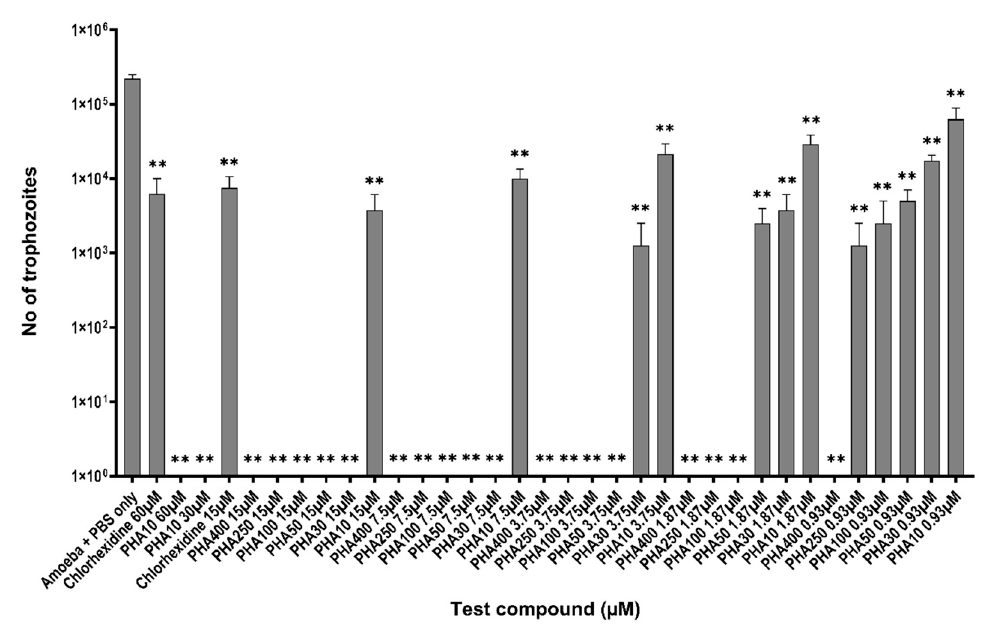
Figure 1. Amoebicidal activity of polyhomoarginine (PHA) peptides against A. castellanii ATCC30868. In brief, 5 × 10 5 A. castellanii trophozoites were incubated with PHA peptides and chlorhexidine at 30 °C for 24 h after which viability was determined by staining with Trypan blue using a Neubauer haemocytometer. The results show significant anti-acanthamoeba activity when compared to amoeba+ PBS only (** p < 0.001 using a two-sample t -test and two-tailed distribution). PHA 400 had the highest trophozoite killing (100%) at 0.93 µM ( p < 0.0001). PHA 30